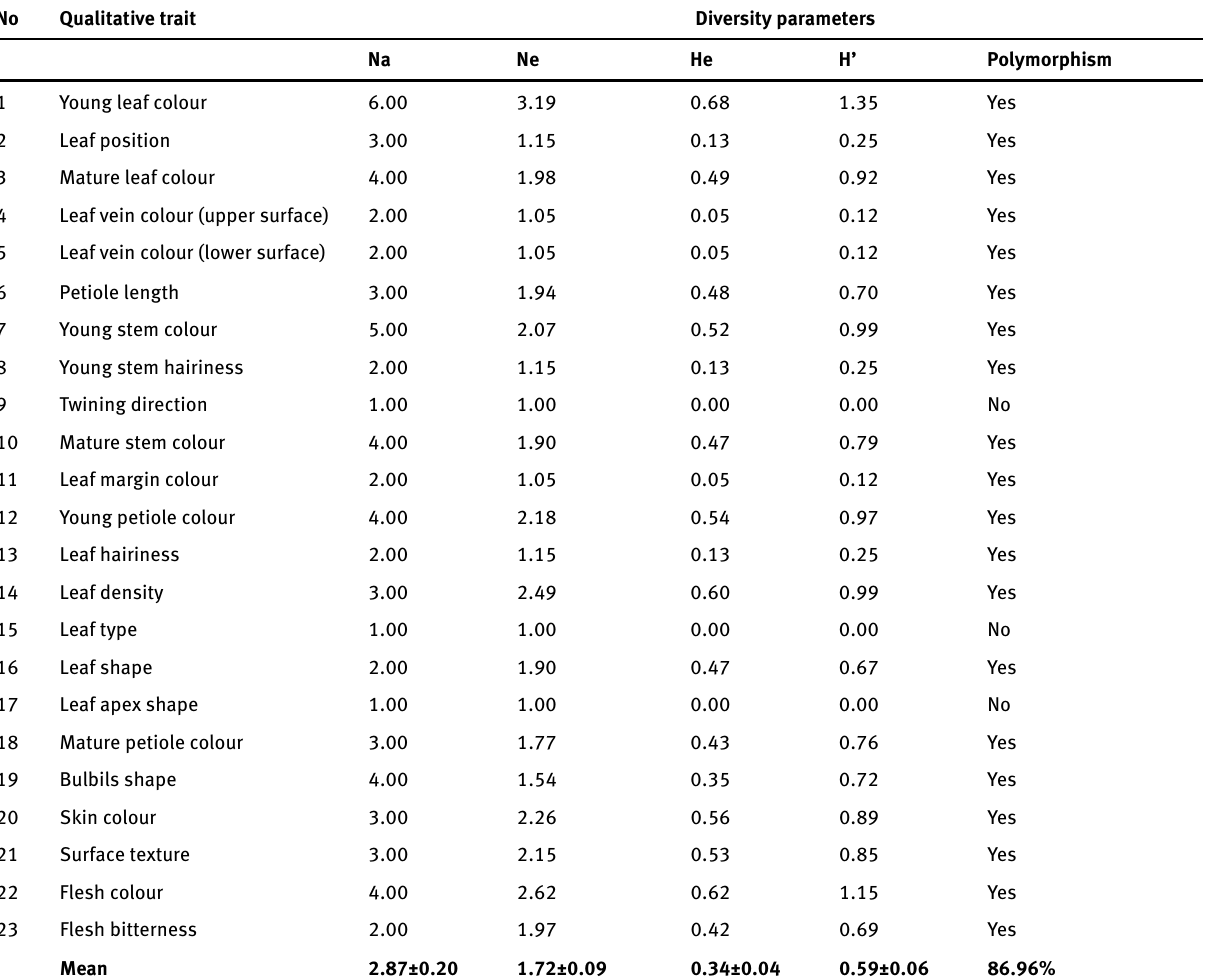
Table 4: Distribution of diversity parameters for twenty three qualitative traits in Dioscorea bulbifera collected in Cameroon No Qualitative trait